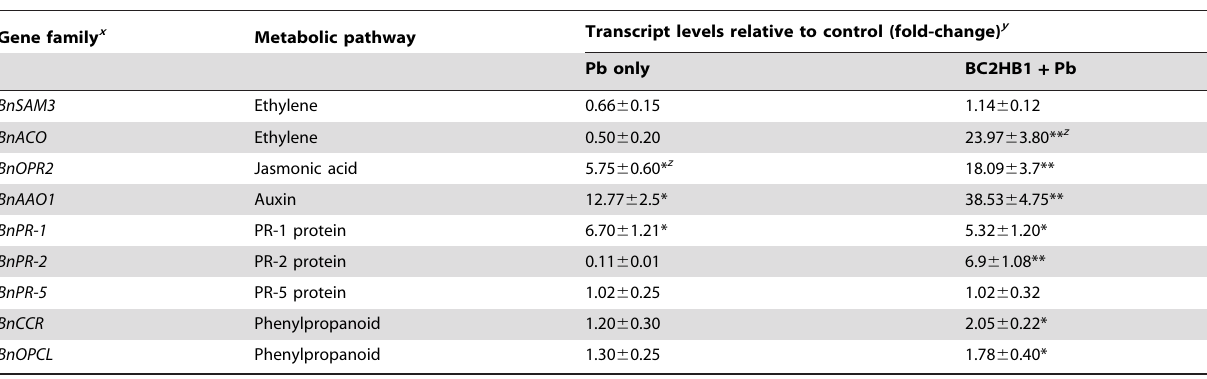
Table 4. The expression (transcript levels) of nine genes potentially related to defence responses in canola at 14 days after a treatment with Heteroconium chaetospira BC2HB1 plus Plasmodiophora brassica (Pb) or Pb alone, relative to the control (n=8).